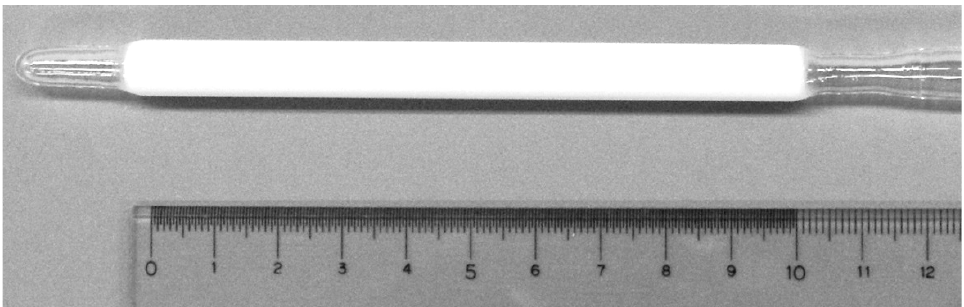
Figure 9. Porous a-silica tube welded to a fused silica glass